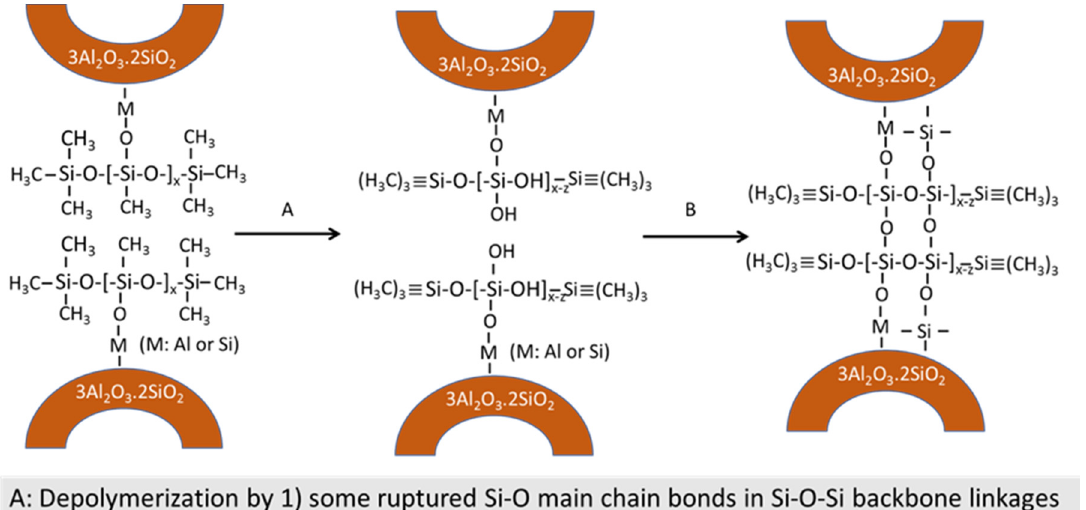
Figure 13. Partial depolymerization and repolymerization pathway of PMHS bonded to the FCS surface at 175 °C.